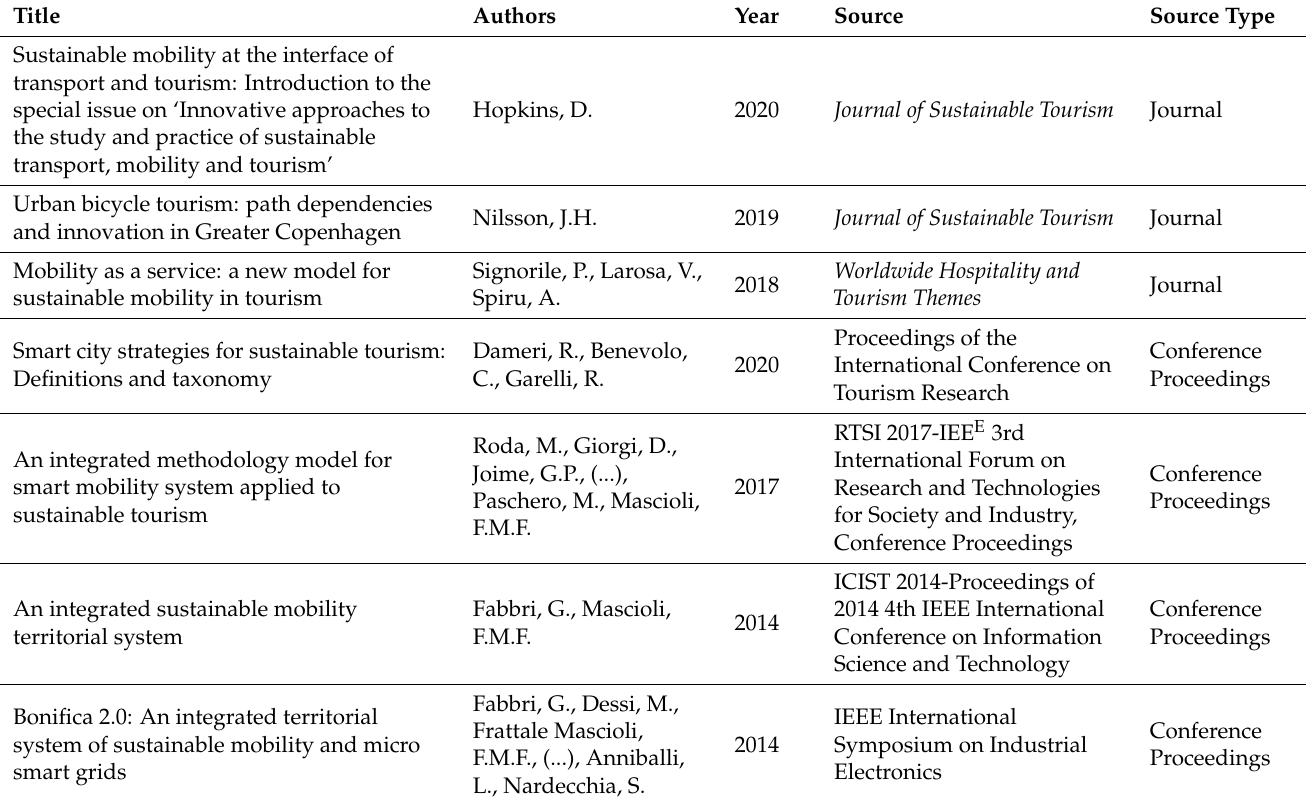
Table 1. Contributions combining sustainable tourism and smart mobility